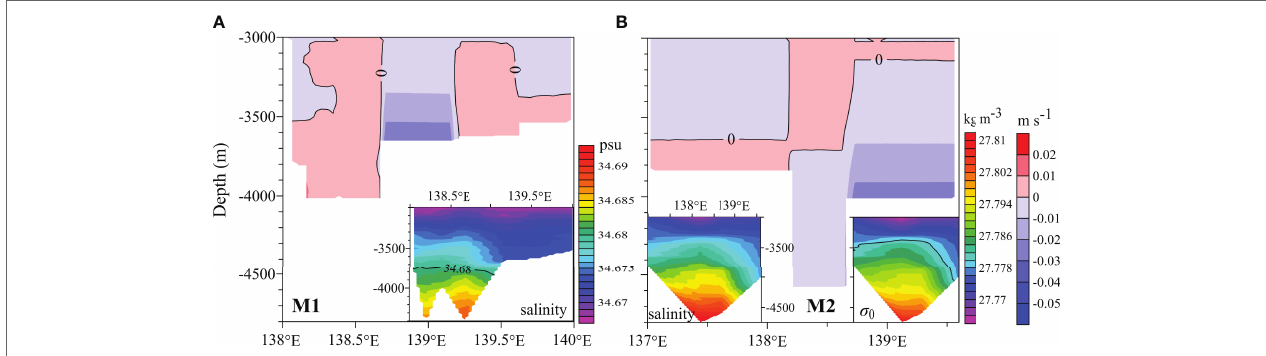
FIGURE 3 | Meridional geostrophic flows at sections M1 (A) and M2 (B) at the sill and the middle of Yap Trench. Salinity and potential density σ 0 are